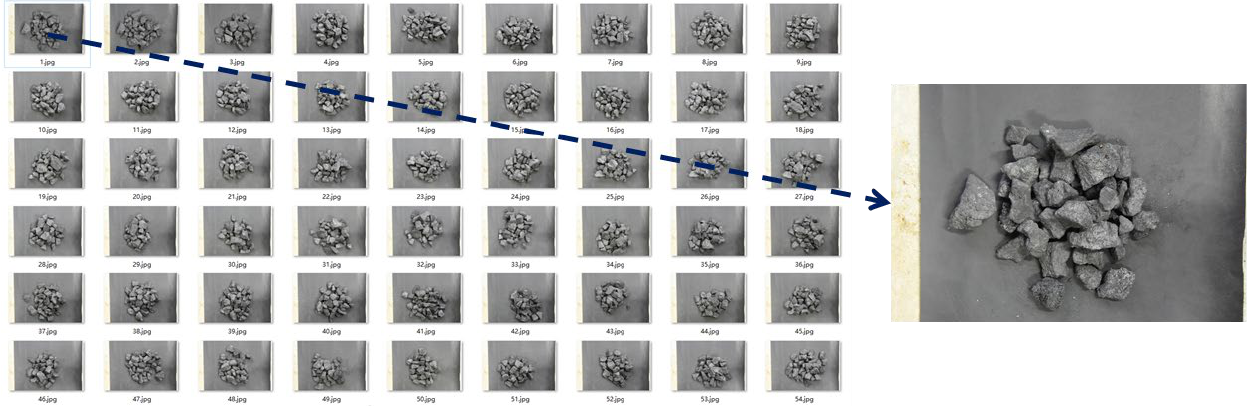
Figure 6. Examples of coke images collected in the lab.